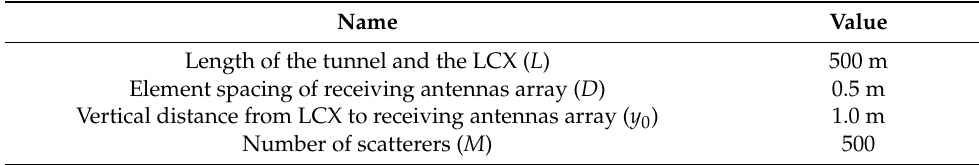
Table 7. Parameters of the LCX MIMO